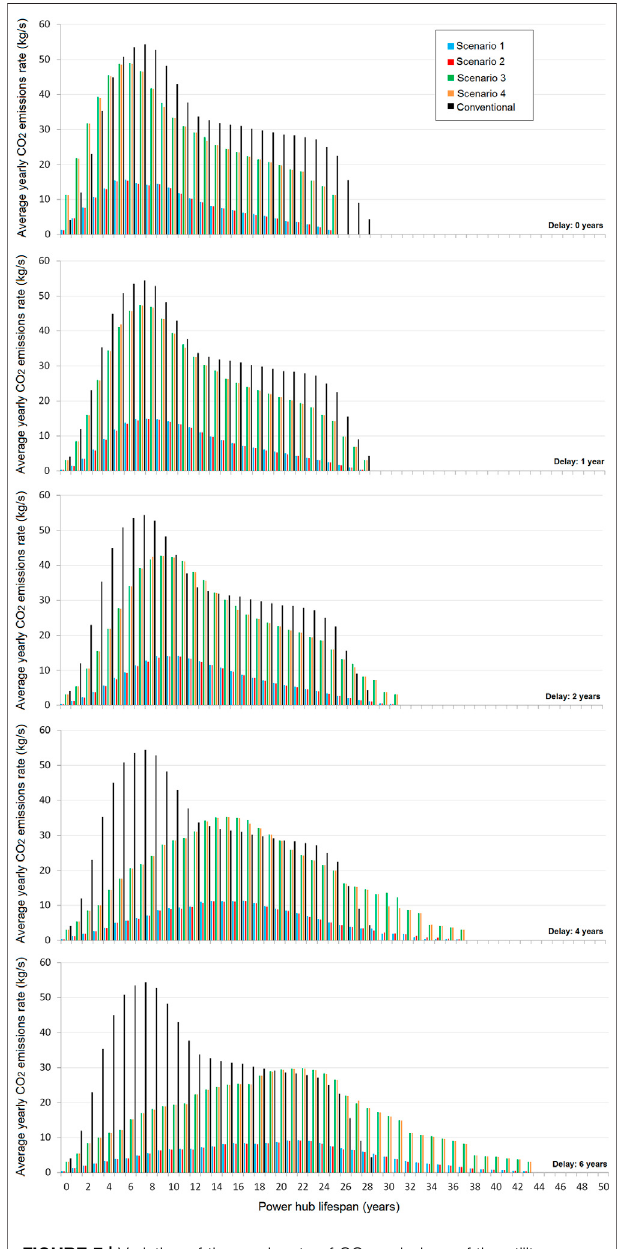
FIGURE 7 | Variation of the yearly rate of CO 2 emissions of the utility systems as a function of the delay in entrance of operation.